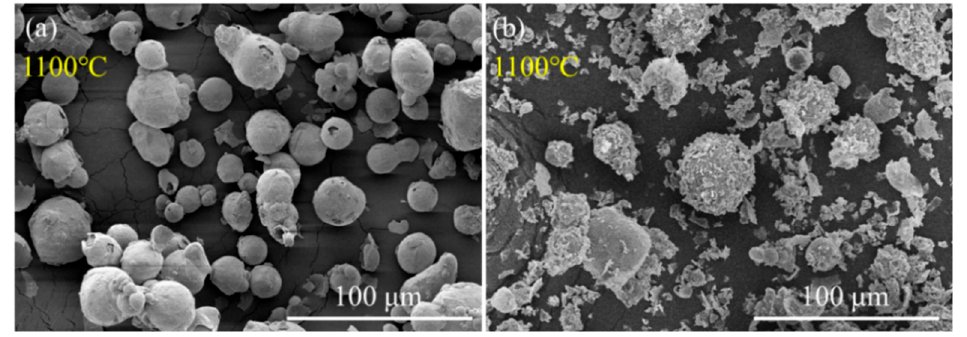
Figure 10. XRD patterns of recovered Al and Al/PTFE powders. ( a ) recovered Al; ( b ) recovered Al/PTFE